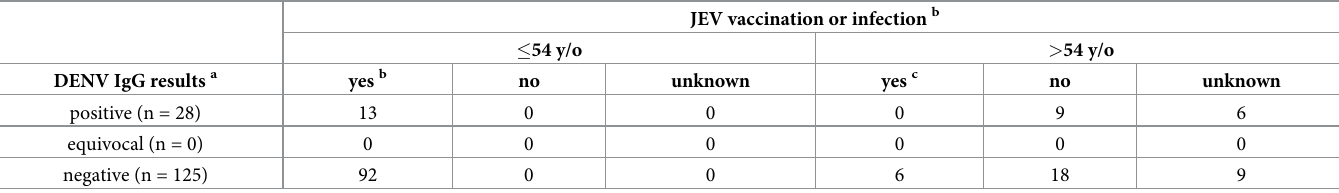
Table 3. DENV IgG positivity and history of JEV vaccination or